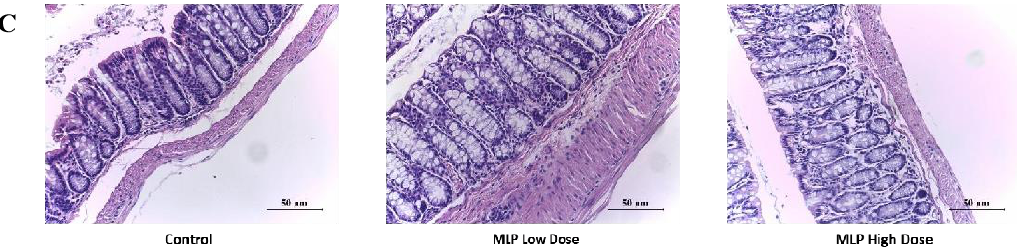
Figure 6. Histological sections (HE) of intestine (( A ): jejunum; ( B ): ileum; ( C ): colon) tissues from the MLP high-dose group and MLP low-dose group.